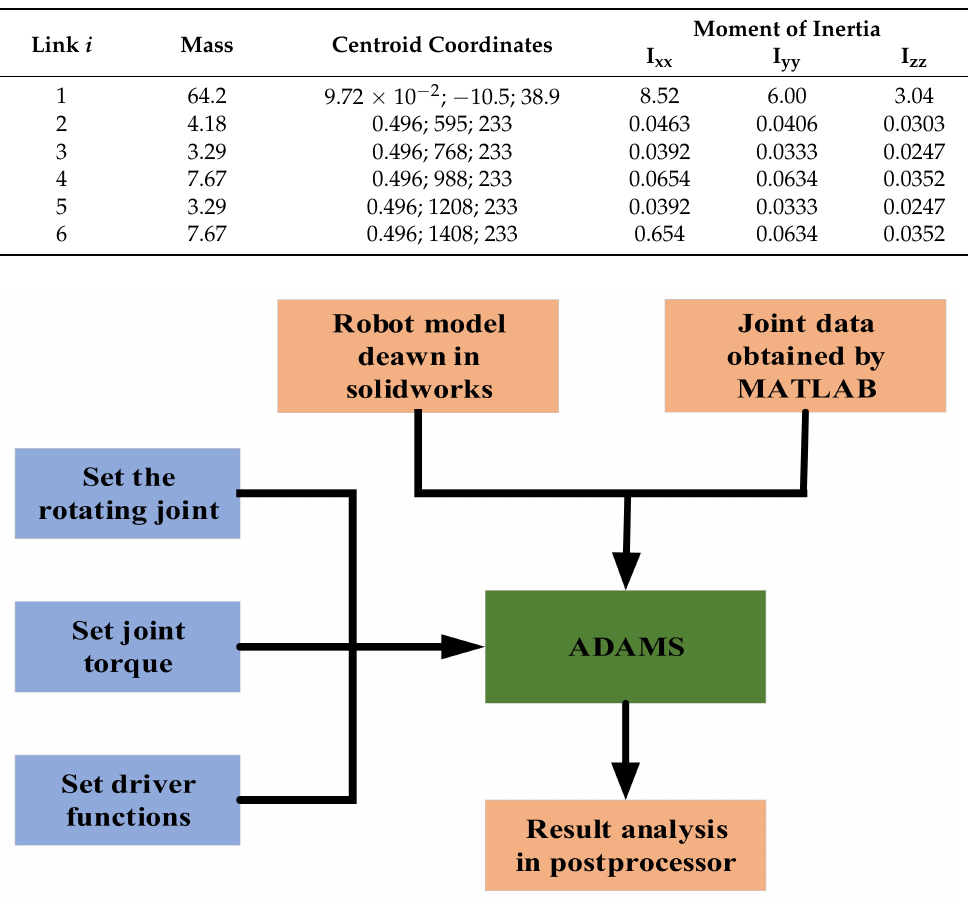
Figure 12. Coordinated simulation process of MATLAB and